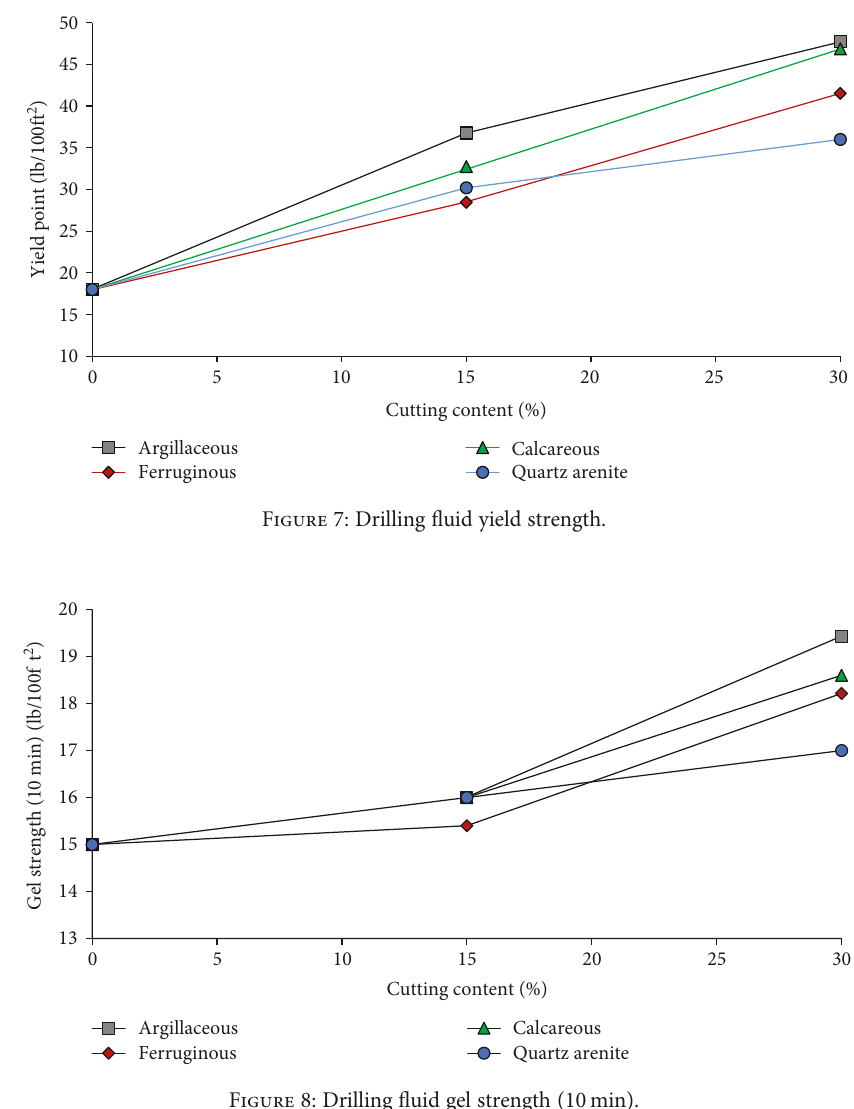
Figure 8: Drilling fl uid gel strength (10 min).